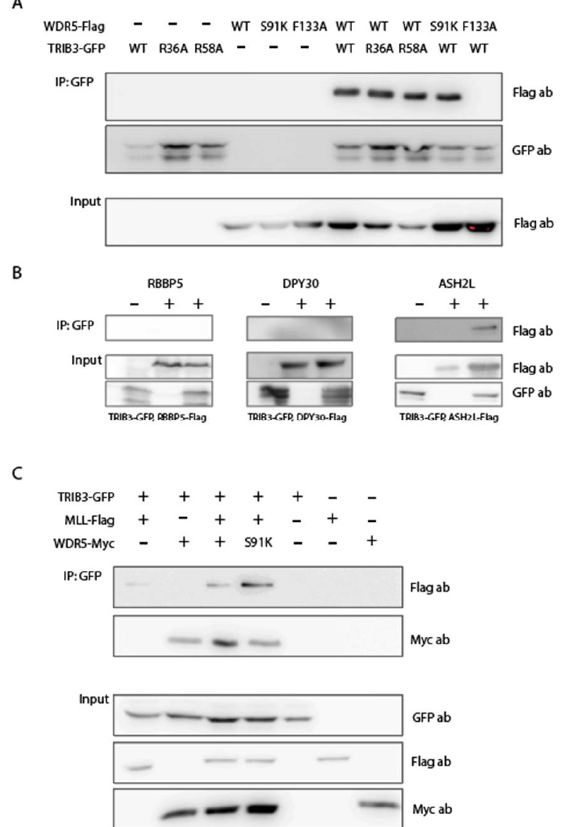
Figure 3. TRIB3 binds to WDR5 and ASHL2, subunits of the WRAD complex and to the SET domain of MLL/SET1 proteins. ( A ) Co-immunoprecipitation (IP) of TRIB3-GFP together with wild-type Flag-WDR5, Flag-WDR5-S91K and Flag-WDR5-F133A, as well as TRIB3-R36A-GFP and TRIB3-R58A- GFP mutants. ( B ) Co-IP of TRIB3-GFP with Flag-RBBP5, Flag-DPY30 and Flag-ASHL2. ( C ) Co-IP of TRIB3-GFP, MLL-Flag and WDR5-MYC. All Co-IPs were performed using HEK293T